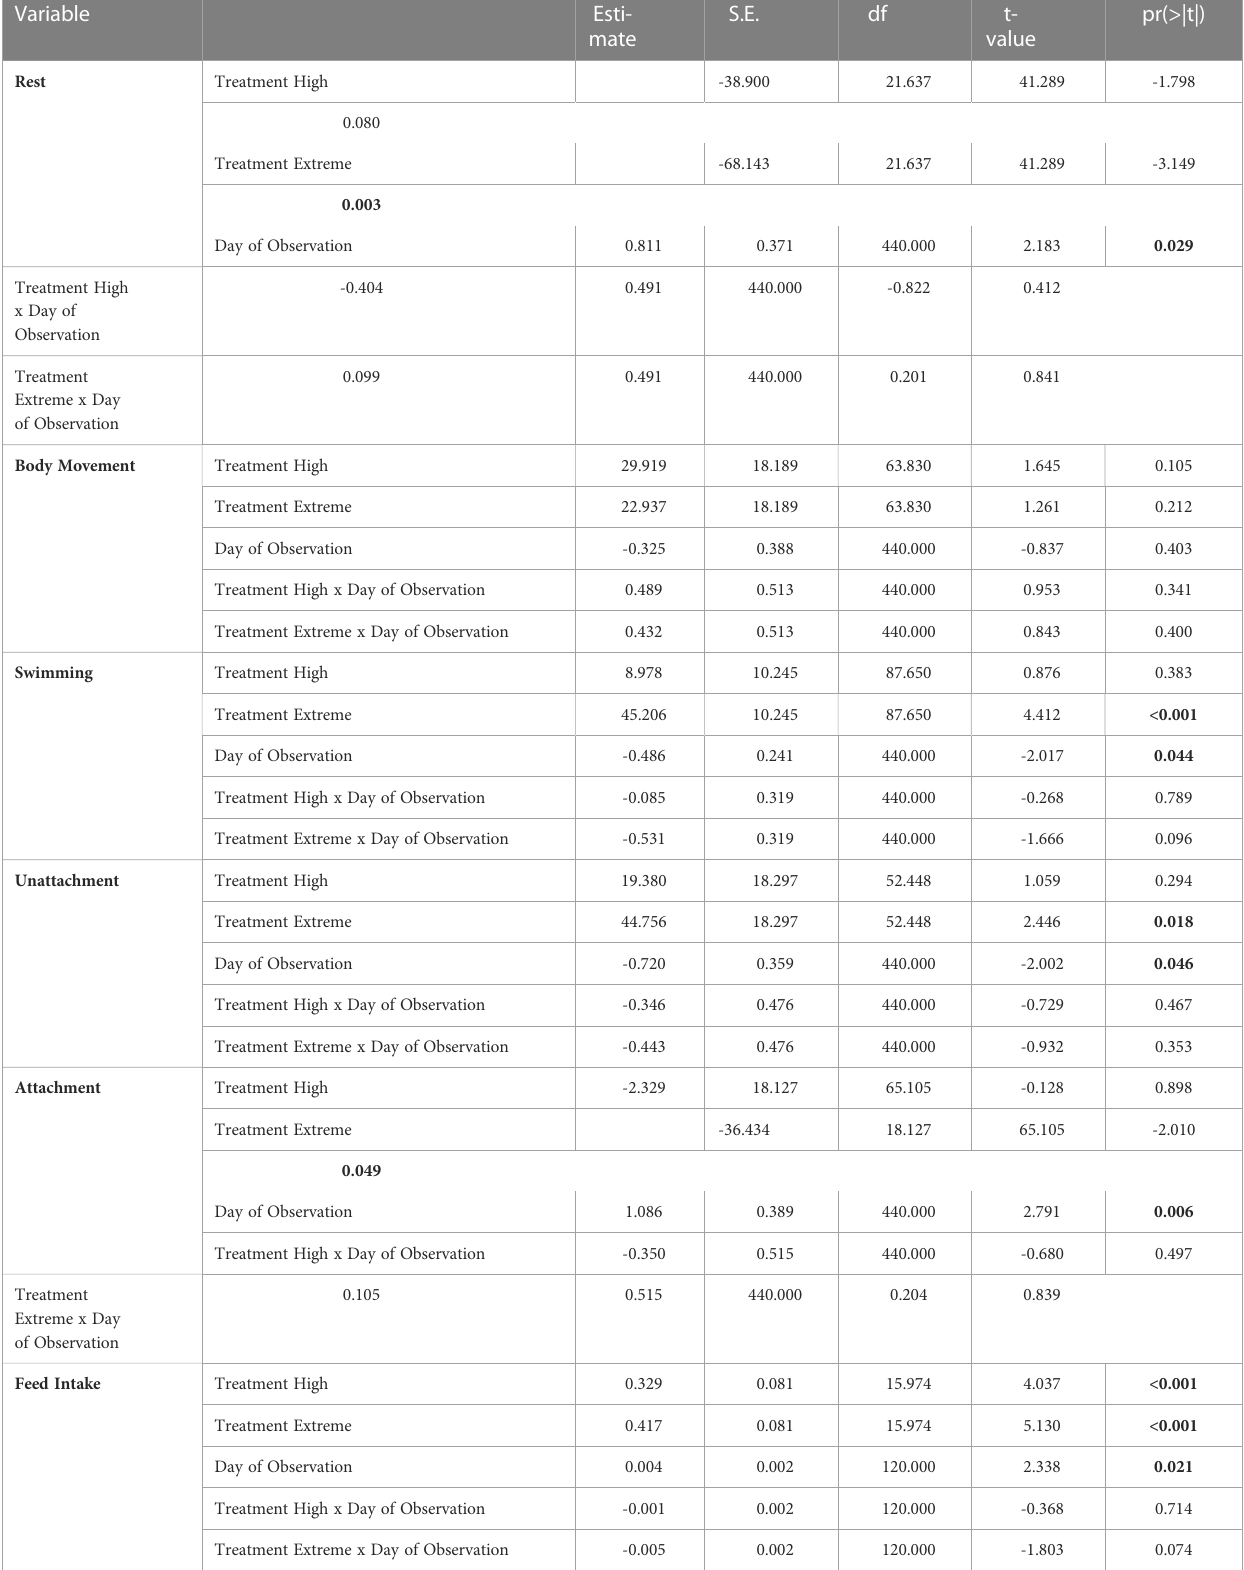
TABLE 2 Statistical results of the Linear mixed effects models on time (s) seahorse spent in rest, body movement, swimming, attached and unattached, and feed intake of long-snouted seahorse exposed to three temperature treatments – control (17°C), high (20°C), and extreme (24°C).